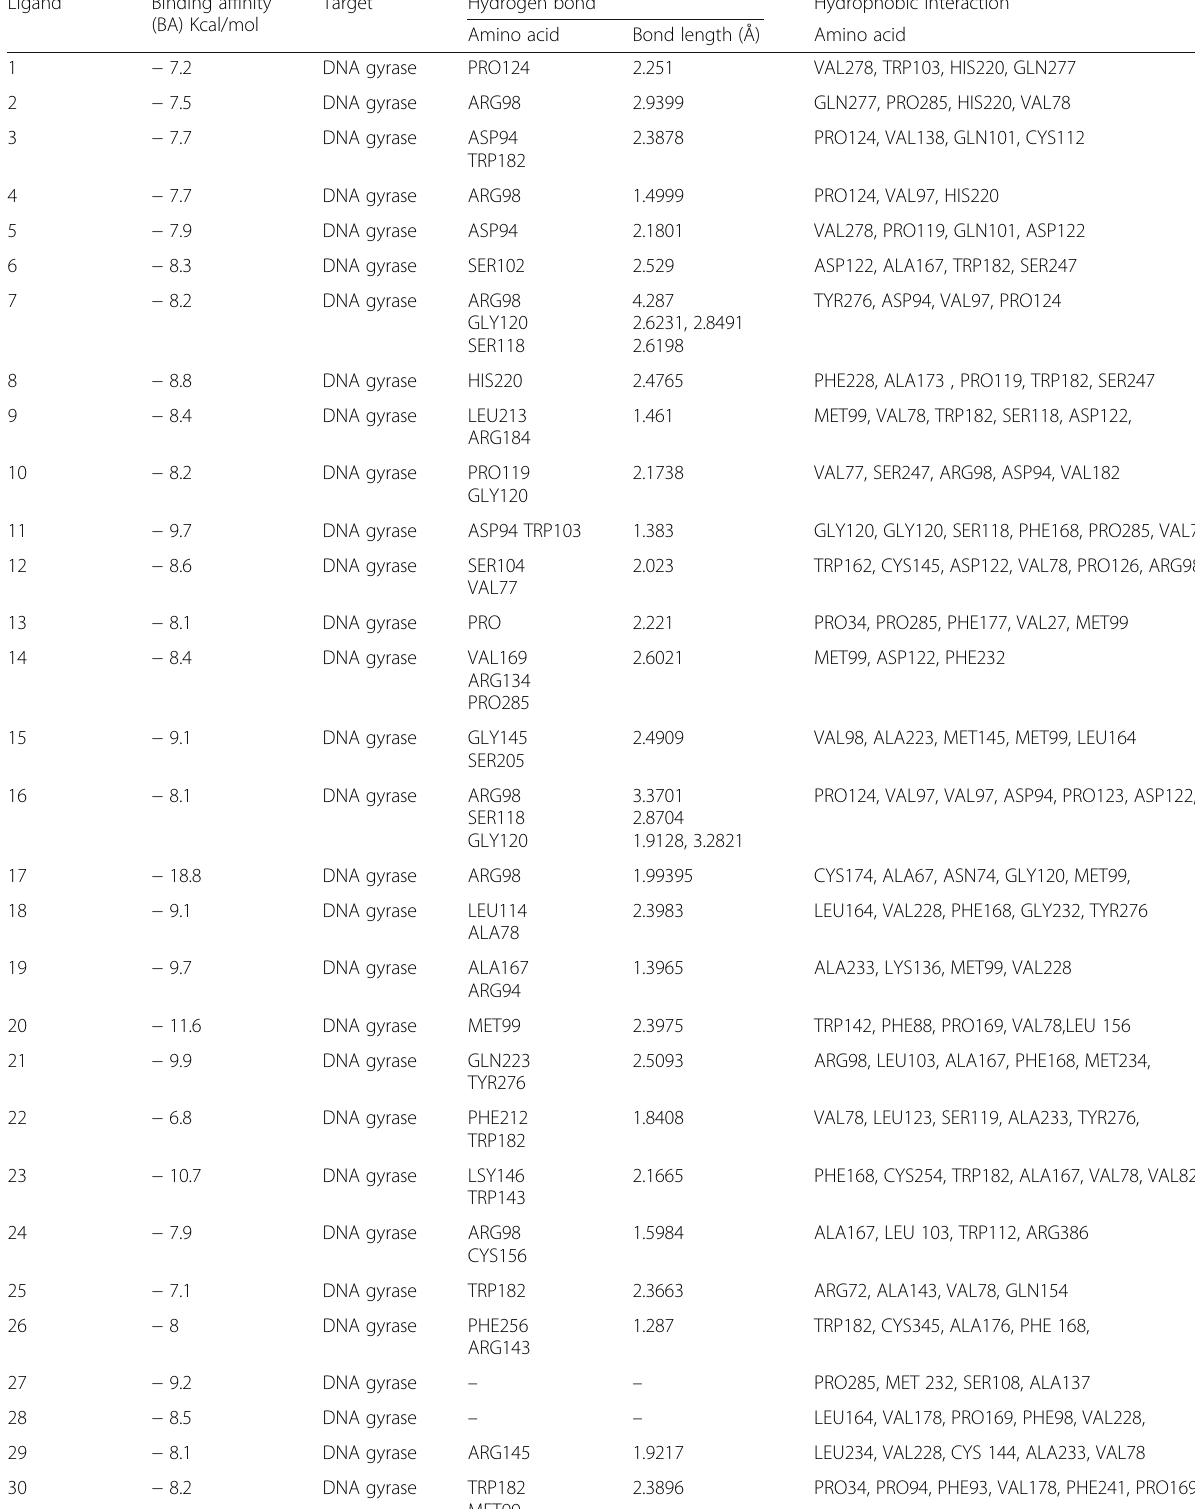
Table 6 Binding affinity, hydrogen bond, and hydrophobic interaction of the ligands (2,4-disubstituted quinolone derivatives) with M. tuberculosis target (DNA